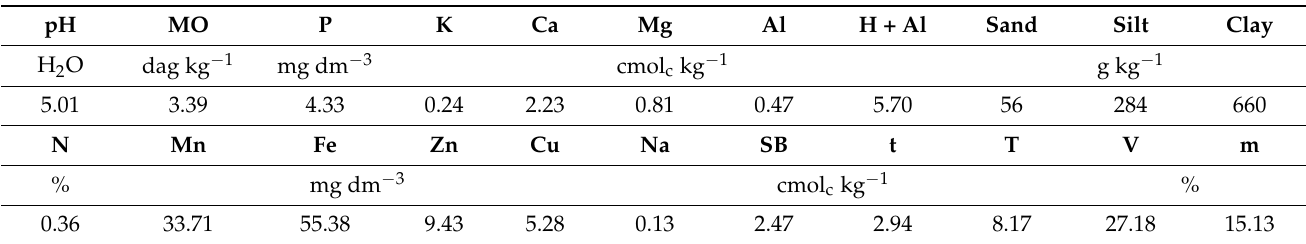
Table 2. Physical and chemical attributes of soil of the study area, depth of 0–20 cm, Fazenda Jaspe, town of Ulianópolis, Pará, Brazil.